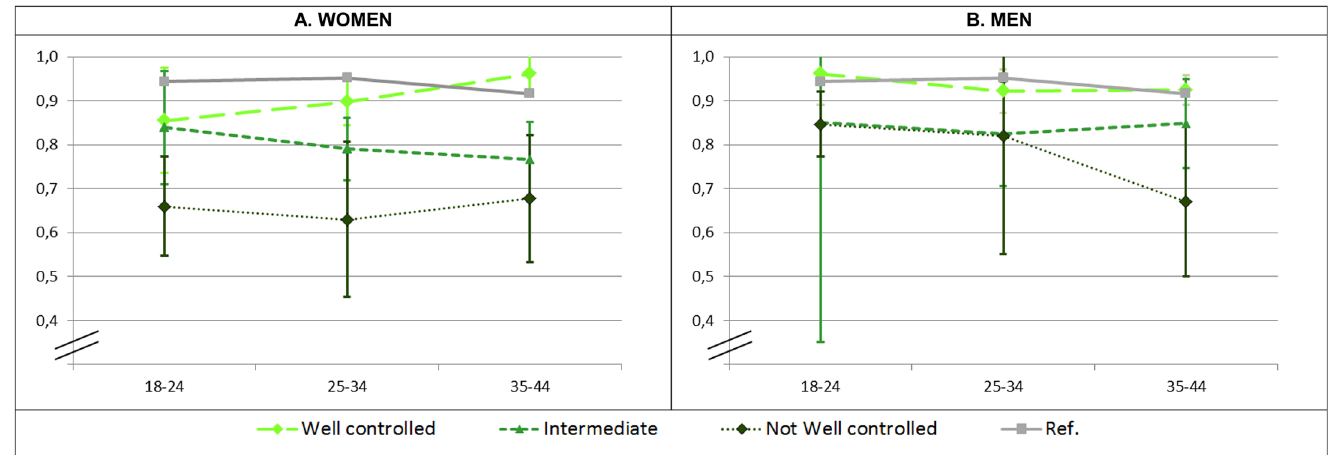
Fig 3. EQ-5D index in patients with asthma, stratified by level of control as measured with ACQ. ACQ = Asthma Control Questionnaire. Well controlled asthma defined as a ACQ score < 0.75; intermediate asthma control as ACQ 0.75–1.5; and not well controlled as ACQ score > 1.5 [31]. Green dotted lines represent mean and 95% Confidence Interval (95%CI) of EQ-5D index in patients with asthma. Grey continuous line represents the mean in French general population-based reference norms